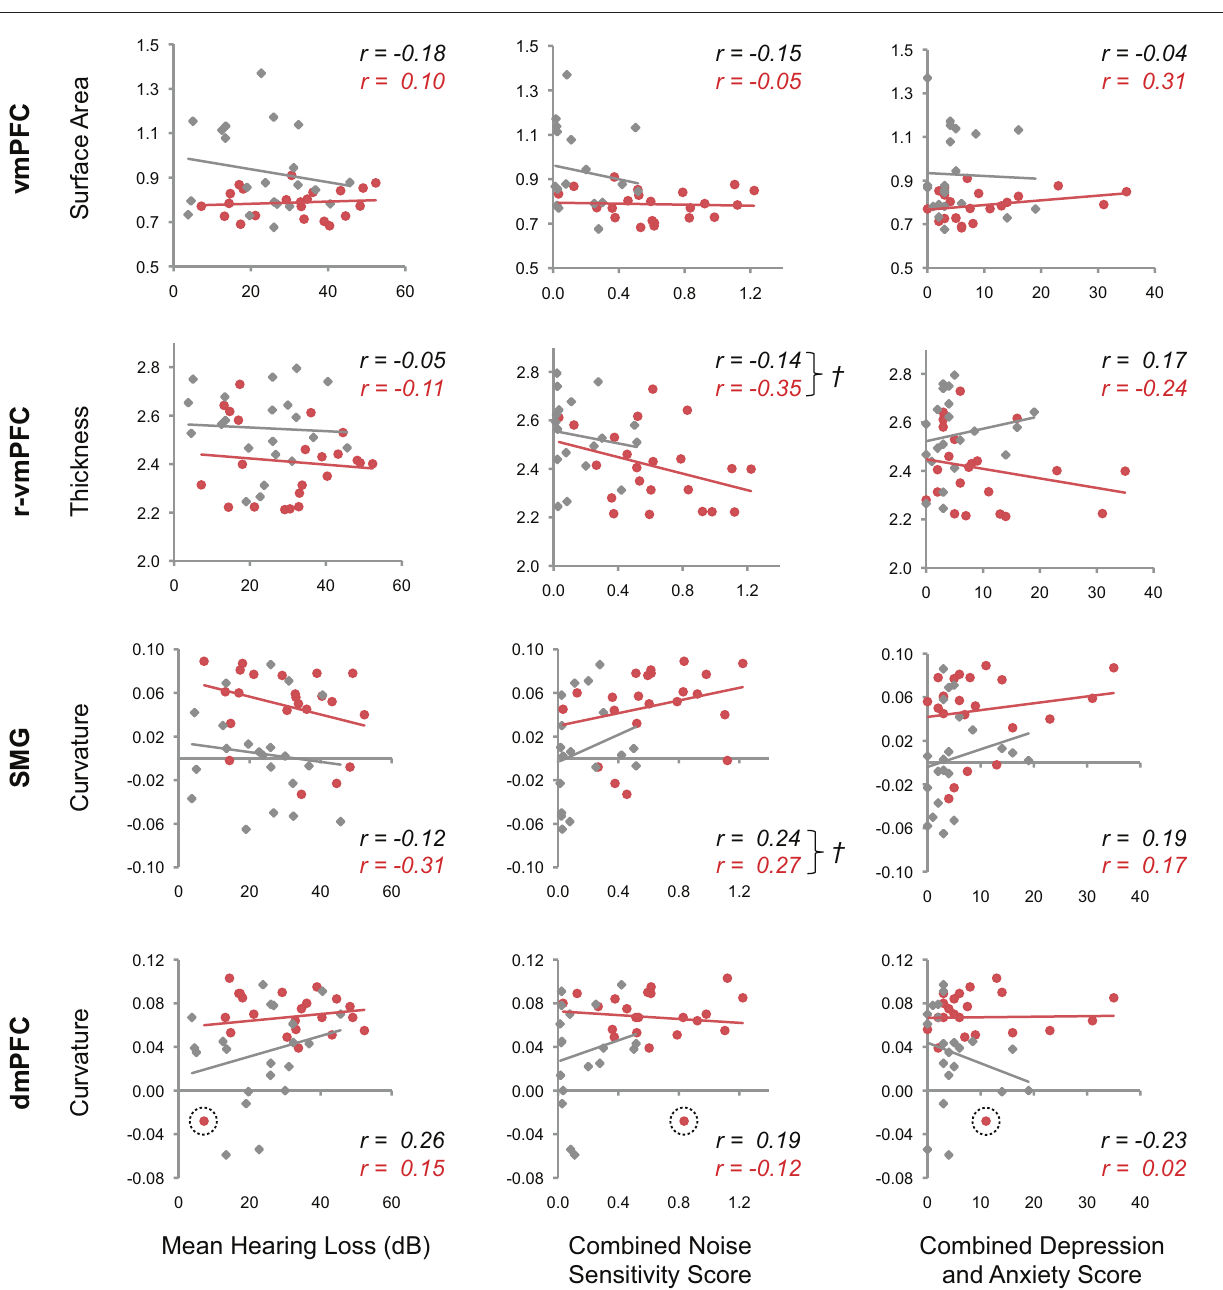
for each group, and insets display corresponding Pearson’s r values for patients (red) and controls (black). Crosses ( † ) mark those plots for which ANCOVA analysis failed to find a difference between groups, and also indicated moderate correlation between morphological features and non-tinnitus factors. An outlier with dmPFC curvature > 3 SD below the mean of tinnitus patients is encircled with a dashed